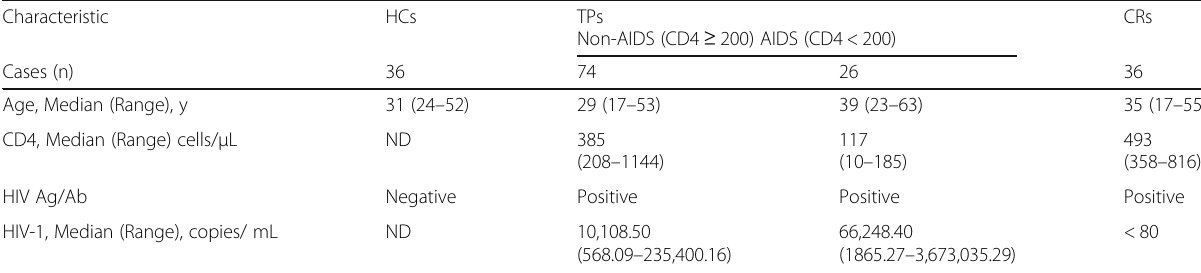
Abbreviations: HC healthy control, TP typical progressor, CR complete